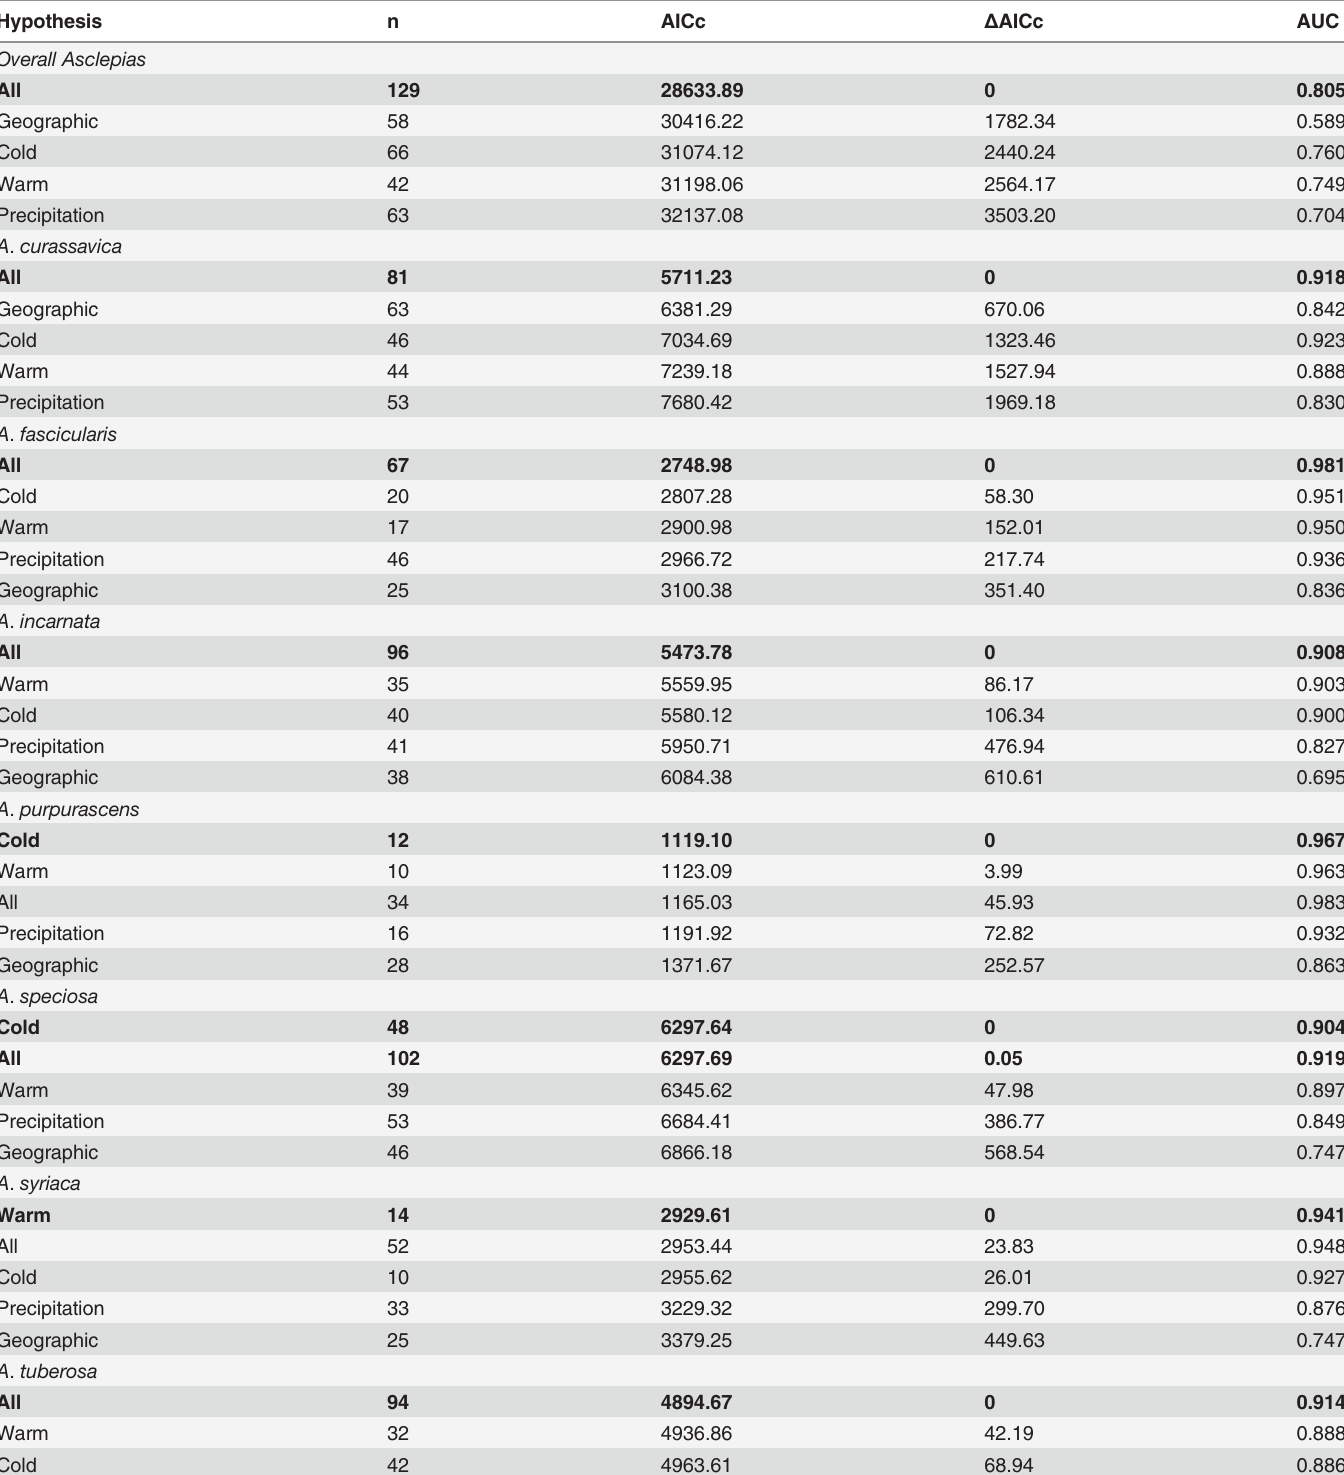
Table 2. Results of AICc model selection for overall Aslcepias distribution and each